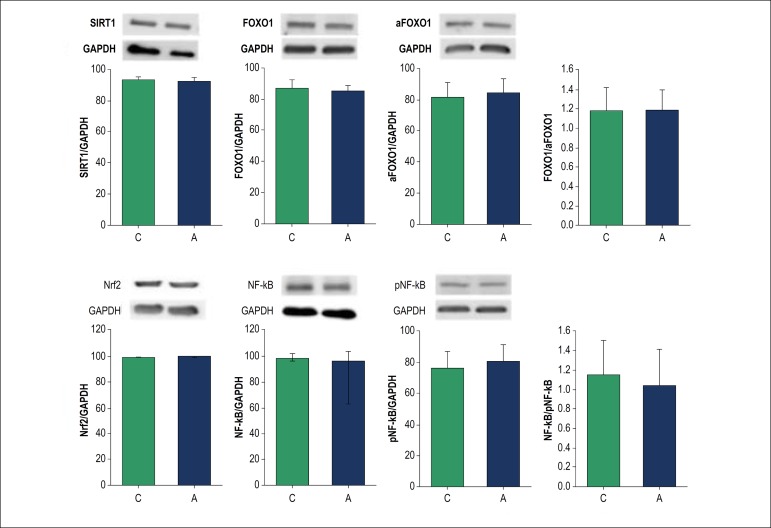
Protein expression evaluated by Western blot. C: control group; A: açaí group; SIRT1: silent information regulator 1; GAPDH: glyceraldehyde-3-phosphate dehydrogenase; FOXO1: forkhead protein 1; aFOXO1: acetylated forkhead protein 1; Nrf-2: nuclear factor erythroid 2; NF-kB: nuclear factor kappa B; pNF-kB: phosphorylated nuclear factor kappa B. All proteins expressions were normalized by GAPDH. There are no differences between groups in protein expression (p > 0.05).